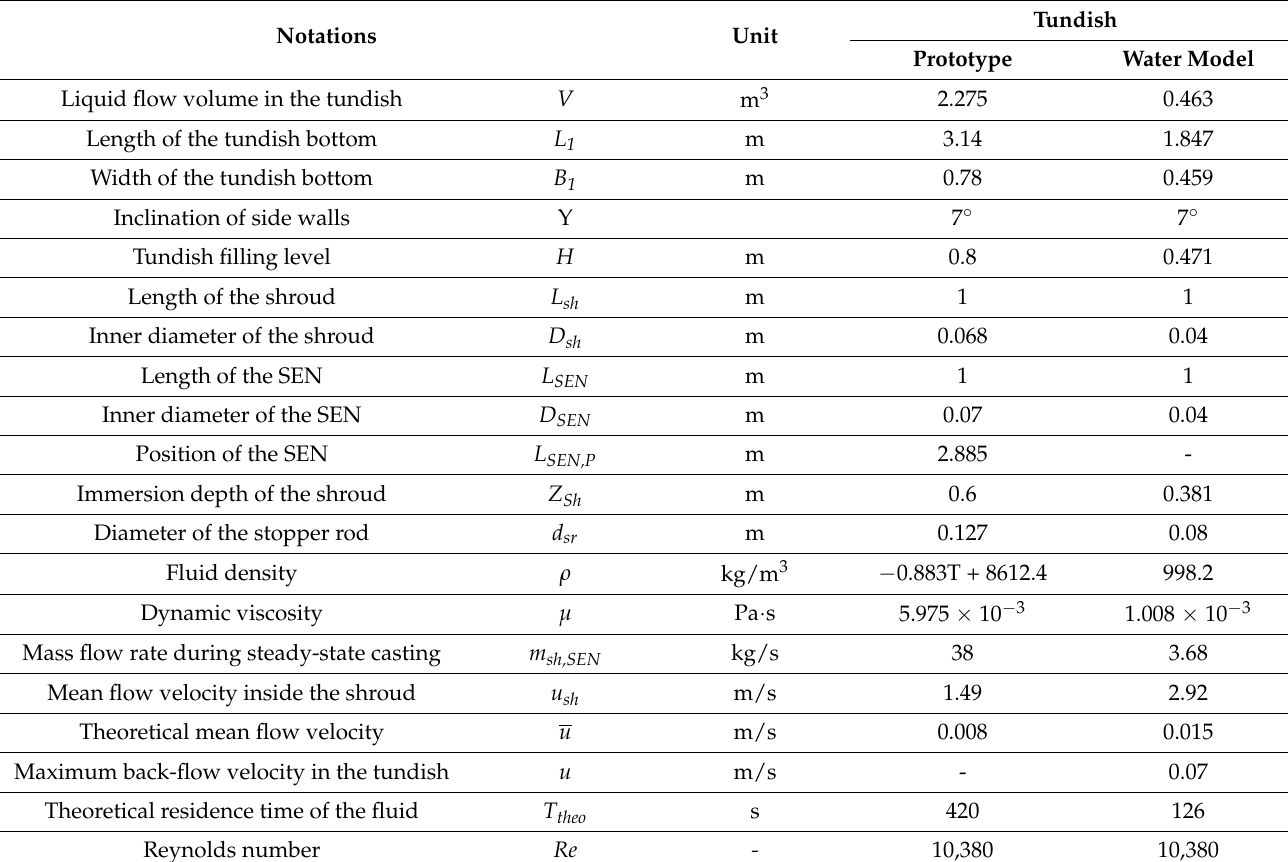
Figure 1. Geometry of the tundish ( a ) front view ( b ) side view. Table 1. Geometry and process data of single-strand tundish